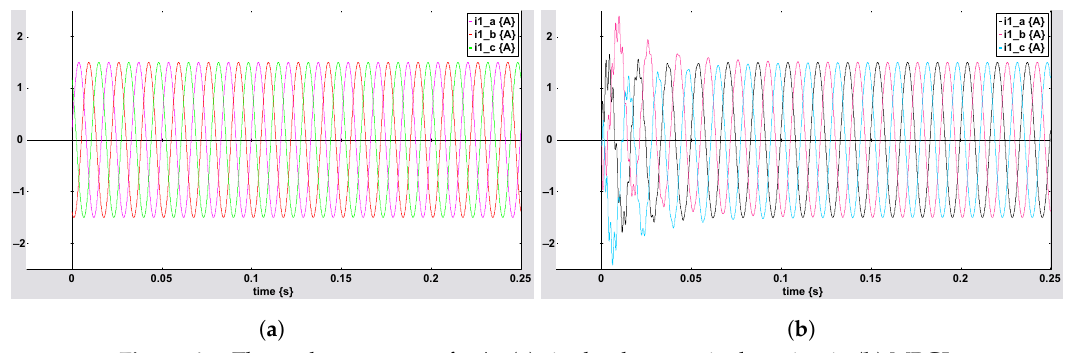
Figure A2. Three-phase currents for i 1 : ( a ) single-phase equivalent circuit; ( b )